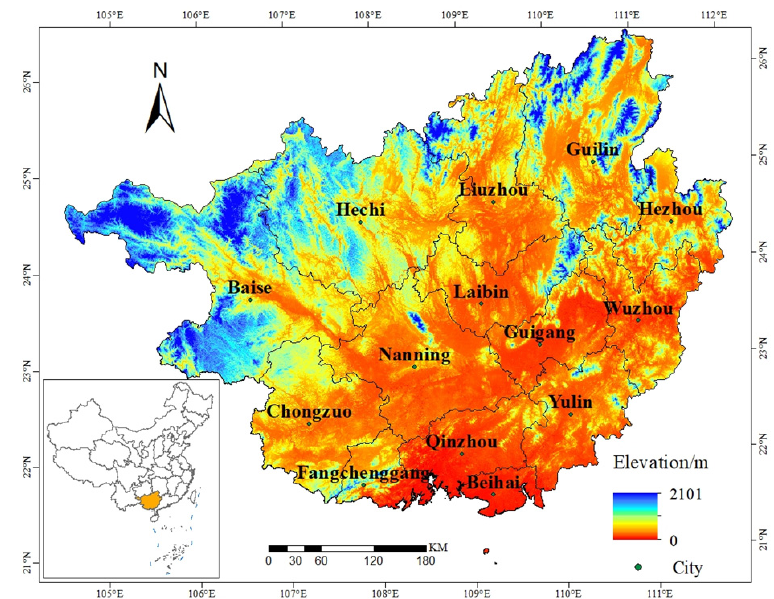
Figure 1. Location of the study